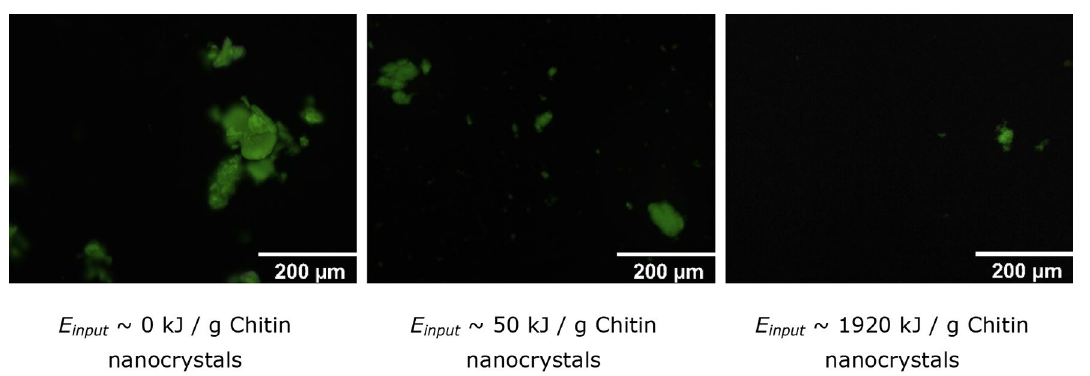
Figure 3. Microscopic pictures of FITC labelled chitin nanocrystal particles after sonication treatments at different E input